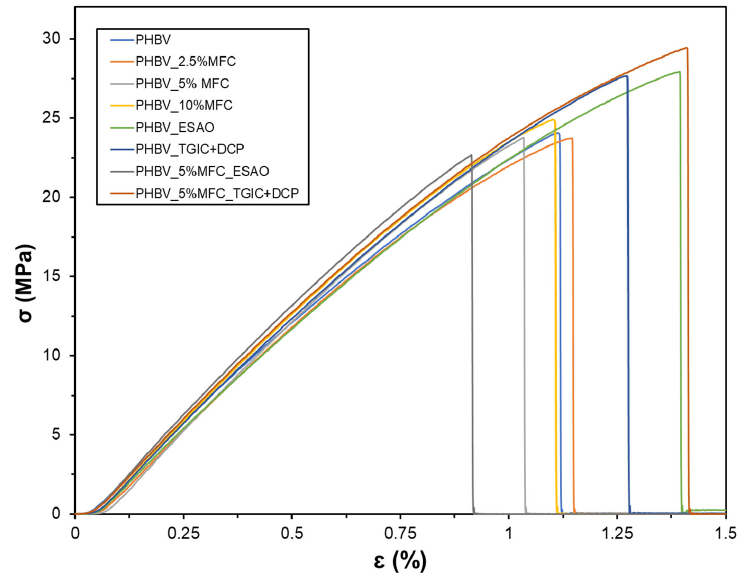
Figure 11. Stress ( σ ) versus strain ( ɛ ) curves of the films of poly(3-hydroxybutyrate- co -3-hydroxyvalerate) (PHBV) with microfibrillated cellulose (MFC) and compatibilized with epoxy-based styrene-acrylic oligomer (ESAO) and with triglycidyl isocyanurate (TGIC) and dicumyl peroxide (DCP). Table 5. Mechanical properties of the films of poly(3-hydroxybutyrate- co -3-hydroxyvalerate) (PHBV) with microfibrillated cellulose (MFC) and compatibilized with epoxy-based styrene-acrylic oligomer (ESAO) and with triglycidyl isocyanurate (TGIC) and dicumyl peroxide (DCP).